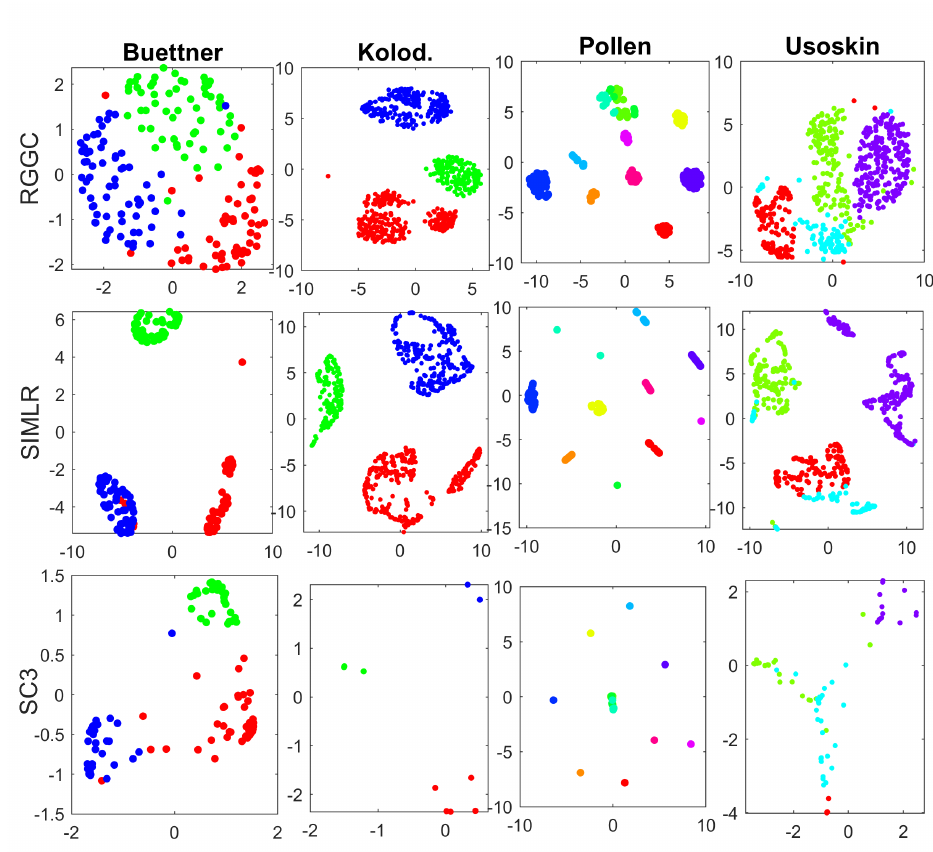
Figure 1. tSNE visualizations with the true clusters of the 4 benchmark data. Similarity (consensus) matrices from RGGC, SIMLR and SC3 are used for tNSE visualization, and different colors represent different true clusters. Top panel: RGGC; Middle panel: SIMLR; Bottom panel: SC3. Datasets to draw the the subplots from left to right: Buettner, Kolodziejczyk, Pollen,